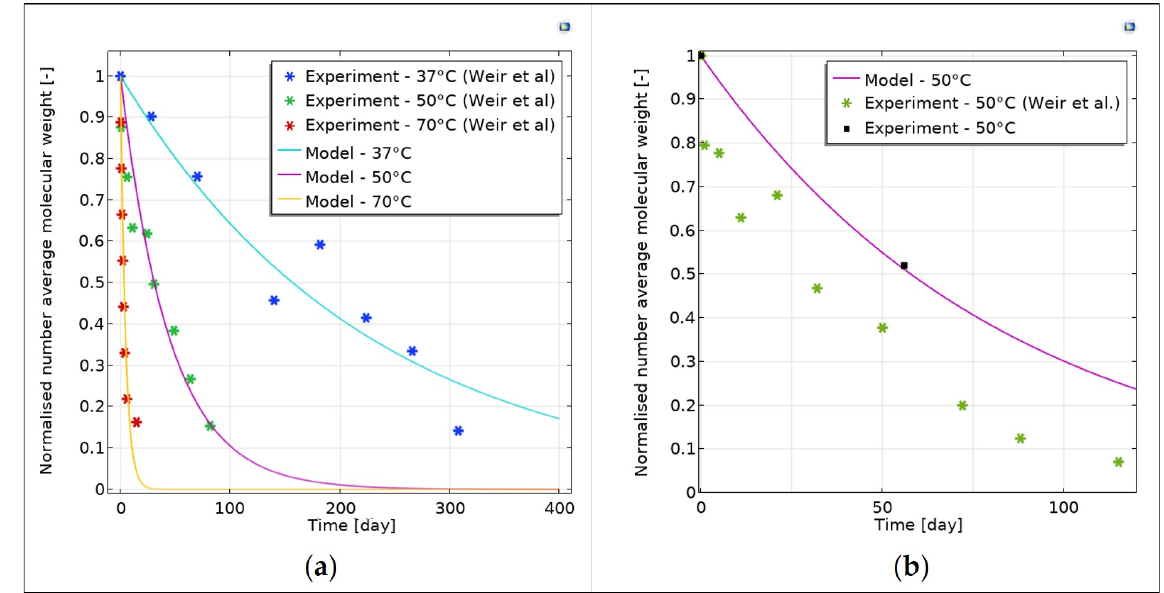
Figure 1. Parameter calibration for PLLA. ( a ) Validation of the Arrhenius constants with the experimental data of PLLA samples provided by Weir et al. [27]; ( b ) calibration and validation for PLLA rods at 50 °C in PBS.